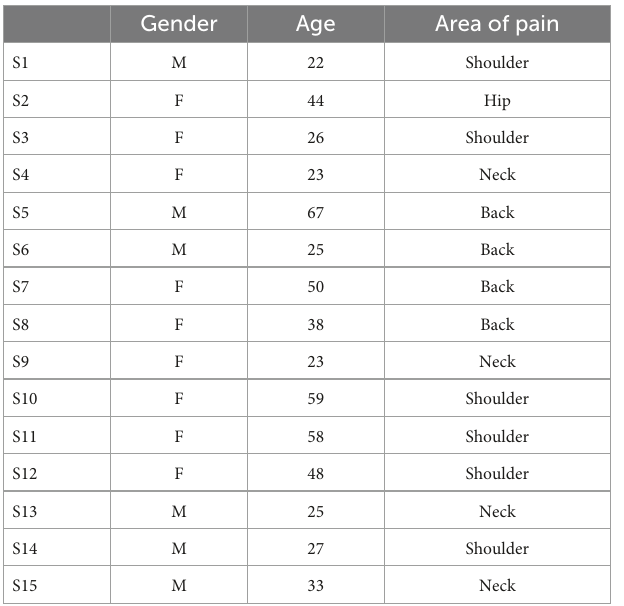
TABLE 1 Basic information of subjects.